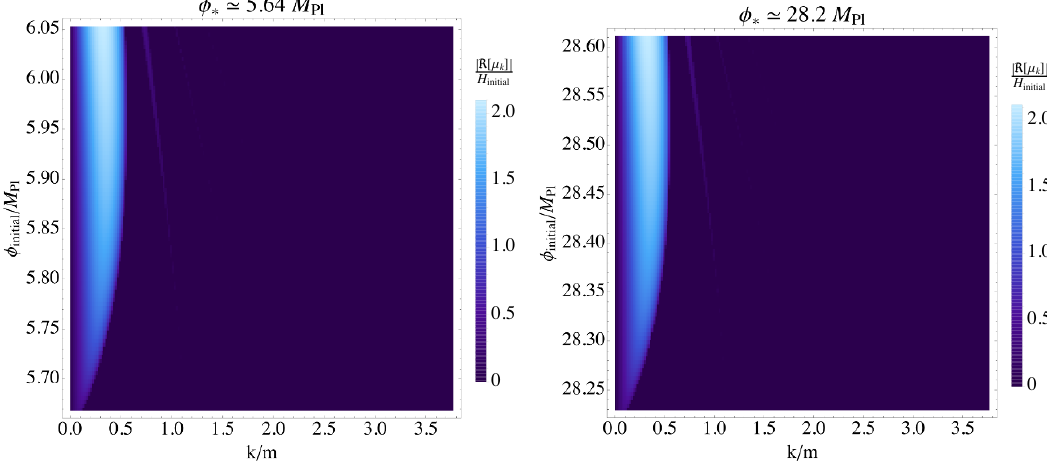
Figure 17 . Instability bands for the volume modulus potential (A.4) in the LVS. The instability bands are represented by the Floquet exponent j< [ (cid:22) k ] j =H as a function of the initial (cid:12)eld value (cid:30) initial . The analysis was performed for two di(cid:11)erent values of (cid:30) (cid:3) : (cid:30) (cid:3) ’ 5 : 64 M Pl (corresponding to 3 ) (left) and for (cid:30) 15 ) V (cid:3) ’ 28 : 2 M Pl (corresponding to V min = 10 min = 10